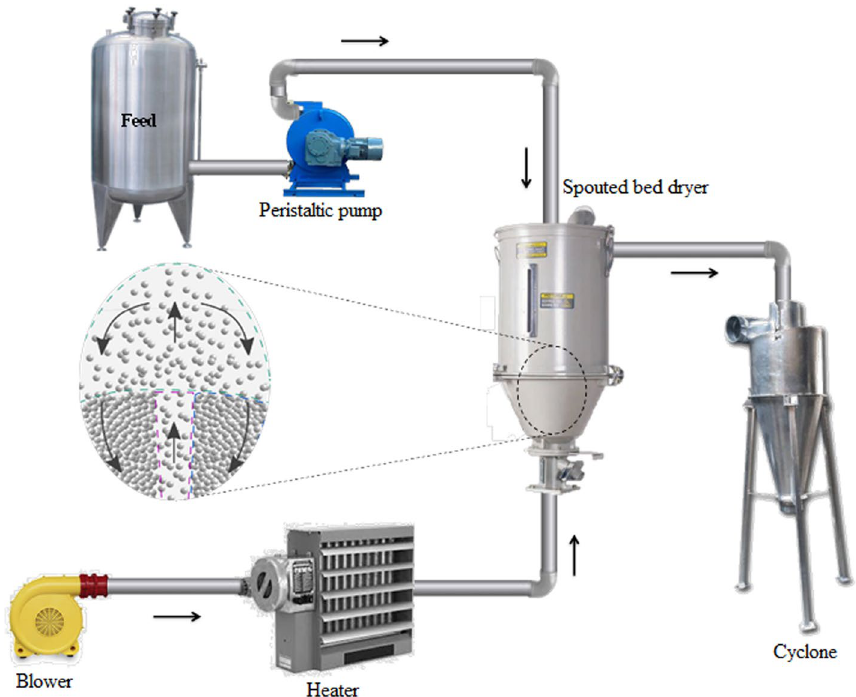
Figure 1. Schematic diagram of the spouted bed